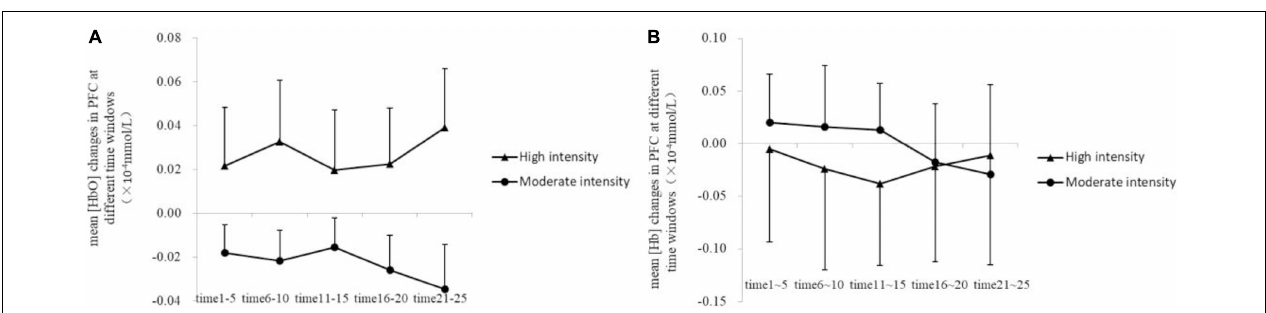
FIGURE 4 | The average brain activation of each channel in moderate-intensity (A) and high-intensity (B) groups during 25-min exercise. Colors represent the t -value of mean [HbO] as compared with 0-value.